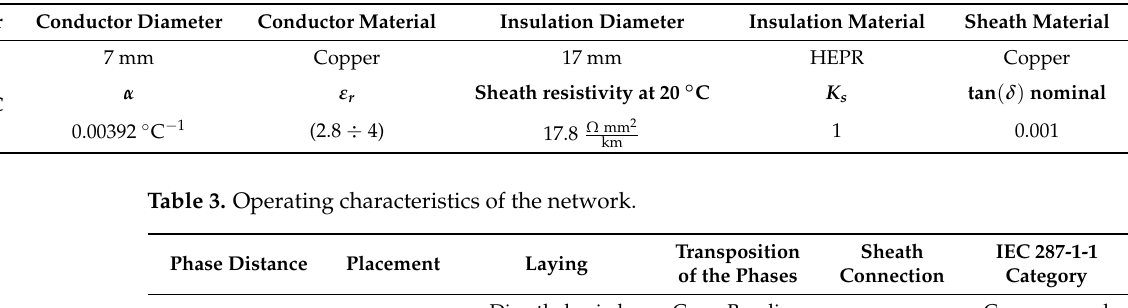
Table 2. Main characteristics of the MV underground cable.